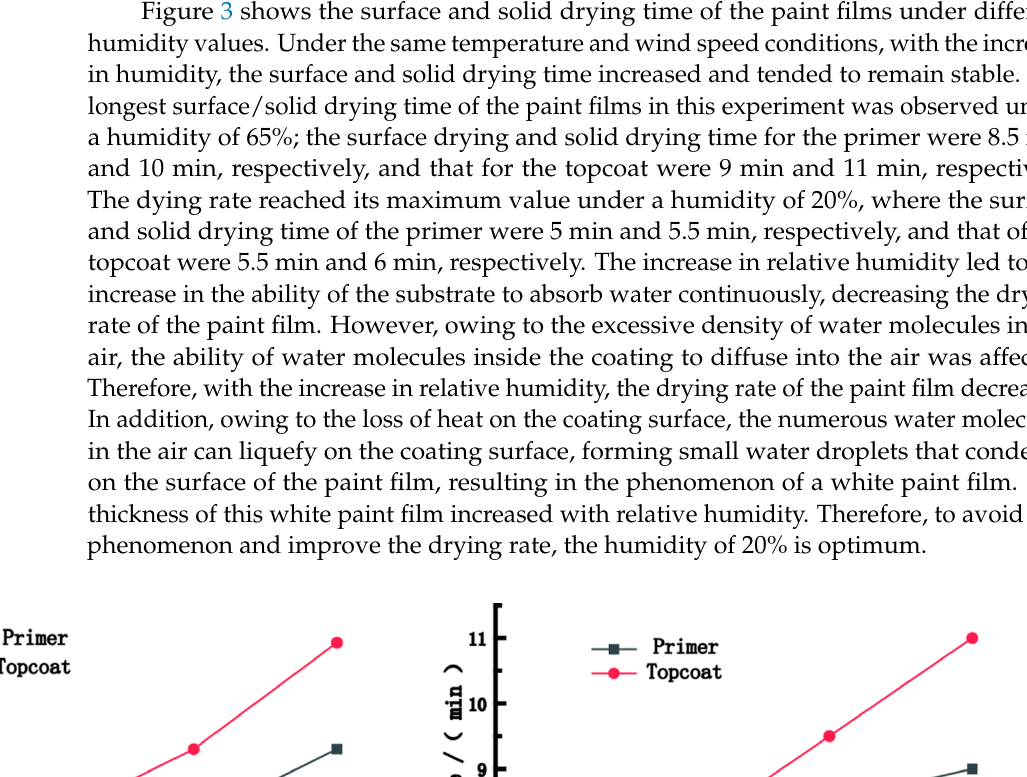
Figure 4. The surface and solid drying time of the paint films under different wind speeds. The longest surface/solid drying time of the paint film in this experiment was ob- served under a wind speed of 0 m/s; the surface and solid drying time of the primer were 7.5 min and 8.5 min, respectively, and those of the topcoat were 8.5 min and 9.5 min, re- spectively. The dying rate reached its maximum value under a wind speed of 1 m/s, where the surface drying and solid drying time of the primer were 5 min and 5.5 min, respec- tively, and those of the topcoat were 5.5 min and 6 min, respectively. Excessive wind speed caused cracks, crusts, wrinkles and other adverse effects on the paint film. Choosing an appropriate wind speed can improve the quality of paint film; thus, a wind speed of 1 m/s is optimum for the drying process of the paint film. 3.2. Effect of the Drying Process on the Performance of Paint Films 3.2.1. Hardness and Adhesion of Paint Films